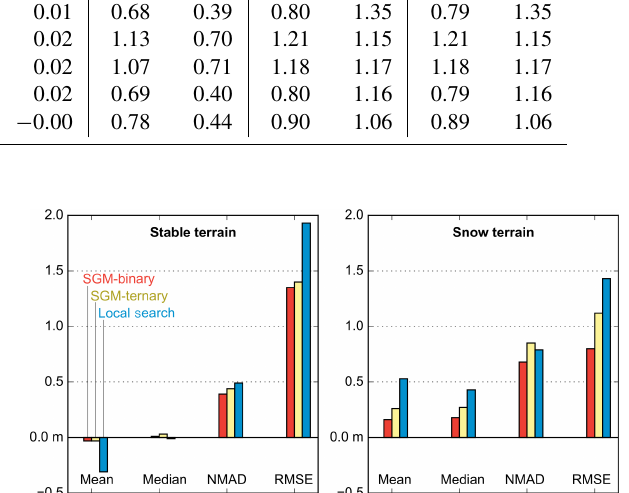
Figure 3. Mean, median, NMAD and RMSE of the residual of HS maps depending on the ASP stereo correlation option. The options compared are the SGM algorithm with the binary census transform cost function (SGM-binary in red), the ternary census transform cost function (SGM-ternary in yellow) and the local-search algo- rithm (local search in